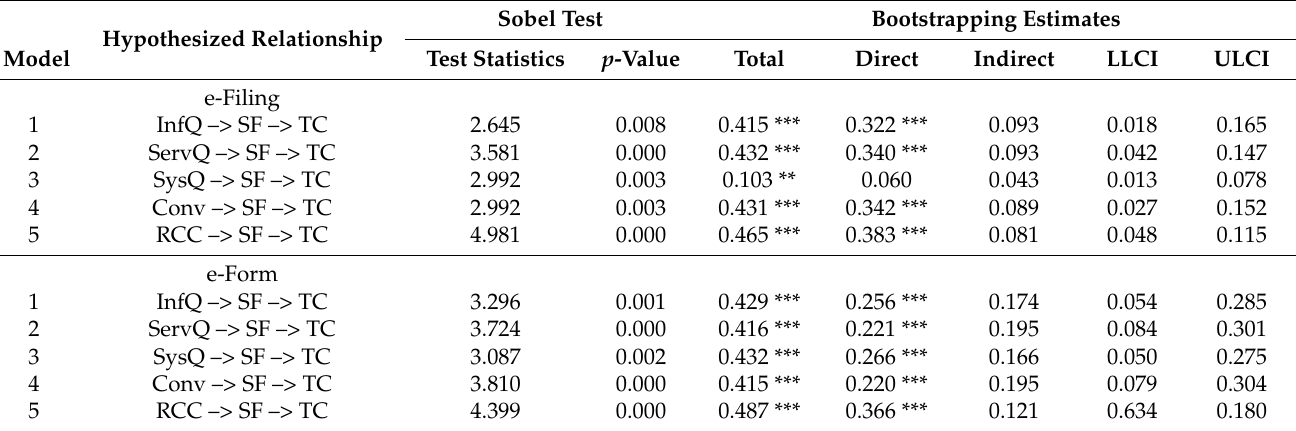
Table 9. Mediation analysis (results of Sobel test and